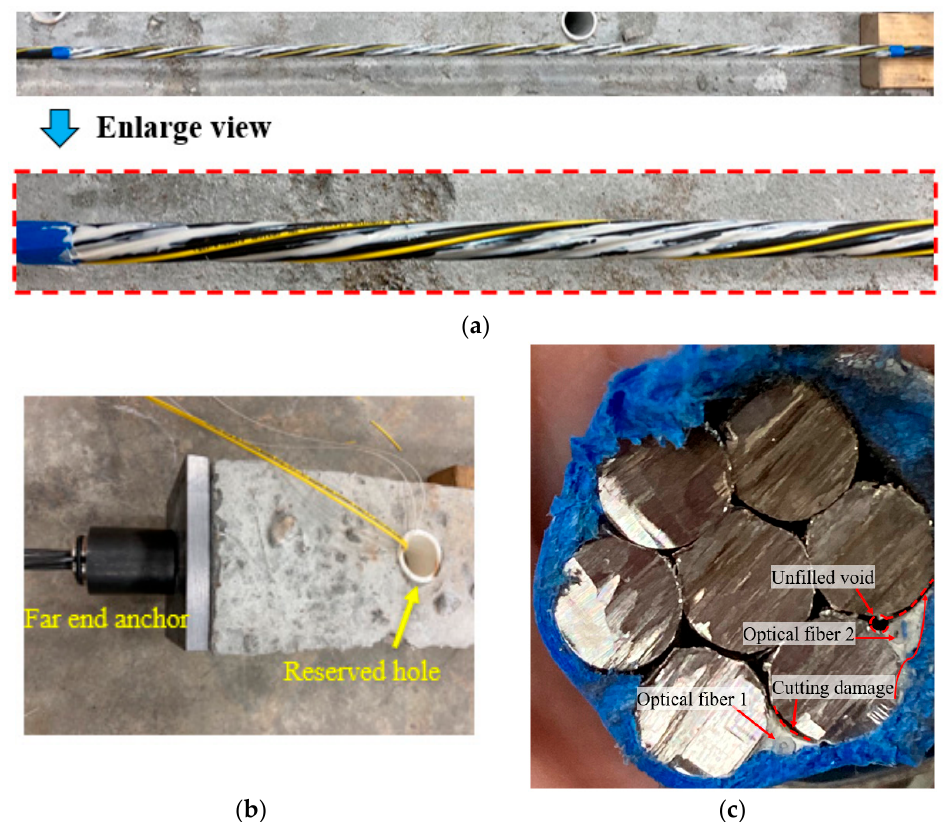
Figure 4. ( a ) Distributed fiber optic sensors’ instrumentation on the steel strand; ( b ) DFOS taken out from the reserved holes; and ( c ) cross-section of a steel strand with optical fibers.